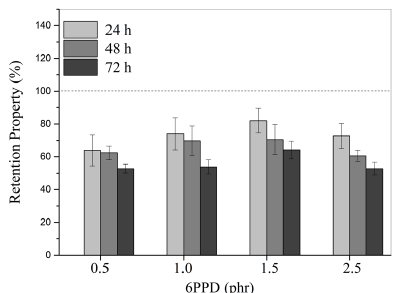
Figure 3. Retention of tear strength in oven thermo-oxidative aging comprising 0.5 phr of TMQ in combination with different 6PPD contents.